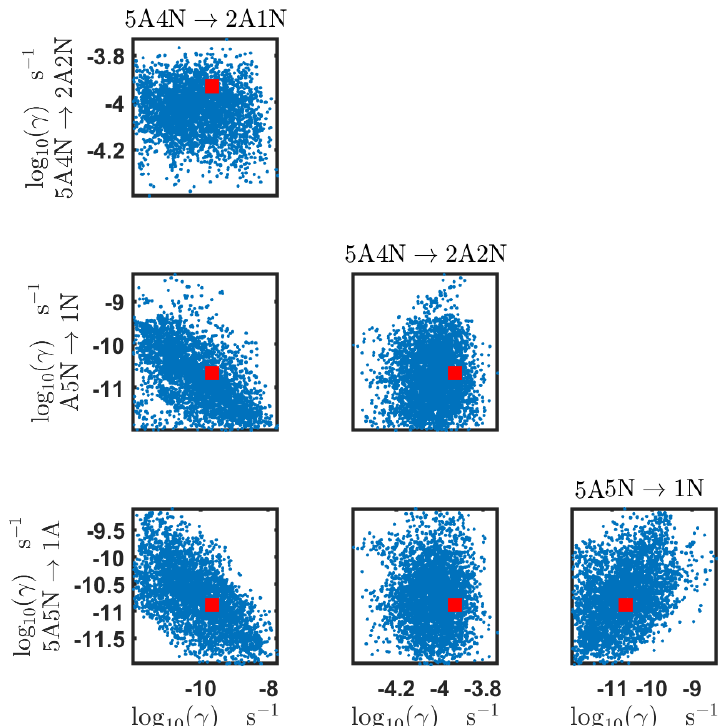
Figure C8. Pairwise marginal posterior distributions (for parameter indexes ranging from 33 to 39) of the base 10 logarithm of the evaporation rates (units given in s − 1 ) from time-dependent measurements of the cluster concentrations with time resolution comprising 1.5min at the temperature 278K. Red rectangles denote the baseline values from Olenius et al. (2013b) used to generate the synthetic data. The notation xAyN corresponds to a cluster with x sulfuric acid and y ammonia